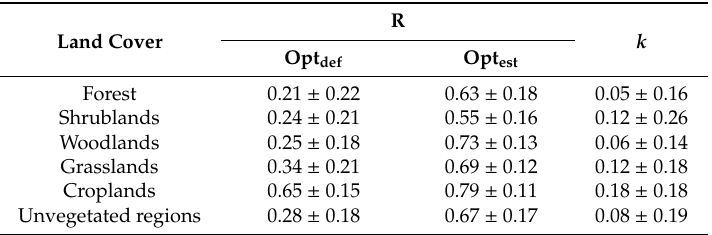
Table 4. Correlation Coe ffi cients of Two LAI Estimation Methods and Parameter Optimization Results over Australia by the MODIS-Derived Six Primary Land Cover